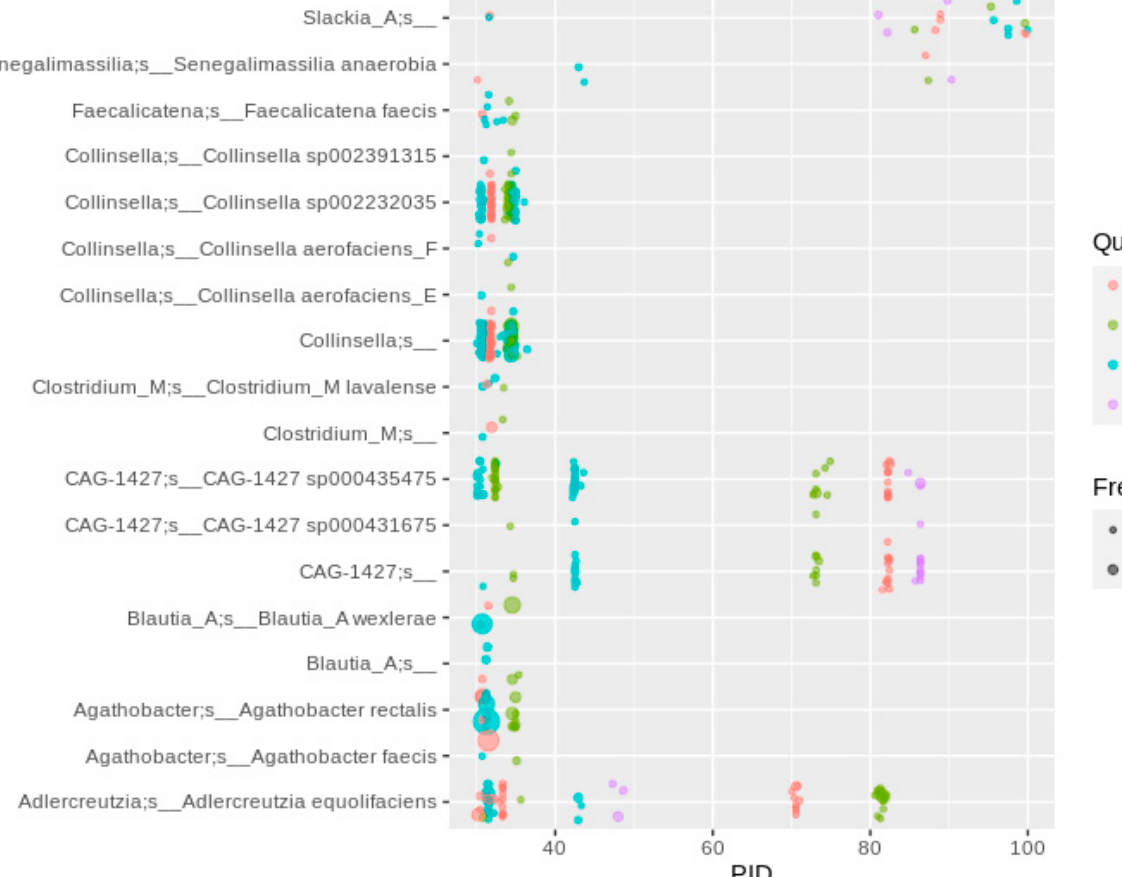
Figure 5. Homologs to enzymes involved in daidzein-to-equol transformation in human gut MAGs. Hits were filtered for the co-occurrence of all three genes required for daidzein-to-equol conversion ( dzr , ddr , tdr ) in a single MAG. For a plot showing the hits to individually occurring genes (mainly dzr ), see Supplementary Figure S7. 2.7. Flavone/Flavonol Reduction, Flavanone/Flavanonol Ring Cleavage, Chalcone Isomerization